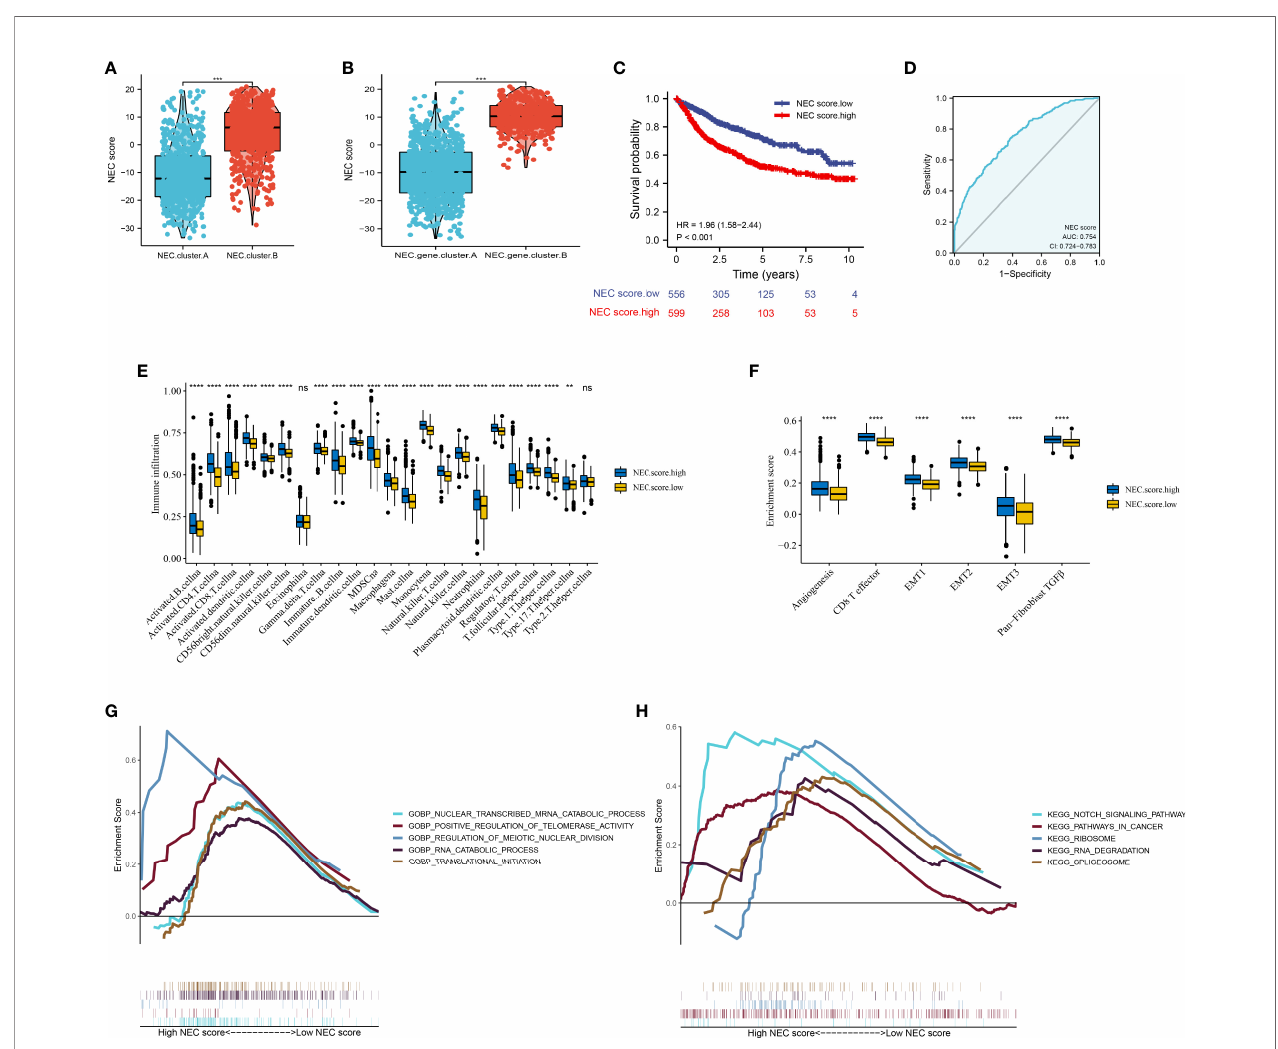
FIGURE 5 | Construction of NEC score. (A) Differences in NEC score among two NEC.clusters in meta cohort (Student ’ s t test). (B) Differences in NEC score among two NEC.gene.clusters in meta cohort (Student ’ s t test). (C) Kaplan-Meier curves for high and low NEC score patient groups. (D) The predictive value of NEC score in meta cohort. (E) The abundance of each TME in fi ltrating cell in high and low NEC score groups (Student ’ s t test). The upper and lower ends of the boxes represented the interquartile range of values. (F) Differences in stroma-activated pathways including EMT, TGF beta, and angiogenesis pathways among high and low NEC score groups (Student ’ s t test). (G) GSEA GO identi fi ed high and low NEC score groups related signaling pathways in HCC. (H) GSEA KEGG identi fi ed high and low NEC score related signaling pathways in